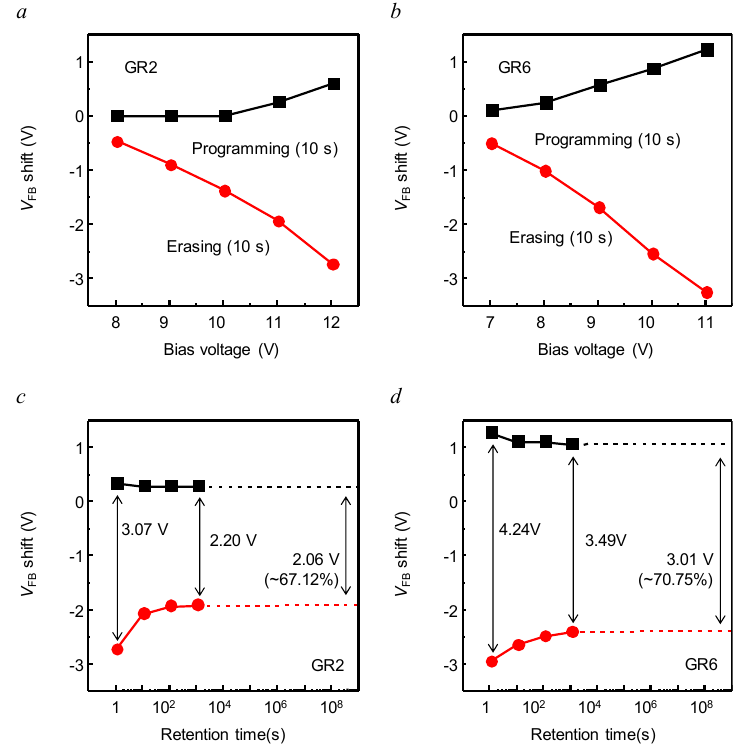
Figure 4. The operation voltages of programming/erasing charges trapped in MIS capacitors for bias voltage with different SiH 4 :N 2 O gas ratio for Si-rich SiO X charge trapping layer: ( a ) GR2 and ( b ) GR6, and extrapolated retention characteristics up to 10 years (10 9 s) of the Metal/SiO 2 /SiO X /SiO X N Y /Si capacitor with different SiH 4 :N 2 O gas ratio for Si-rich SiO X charge trapping layer: ( c ) GR2 and ( d ) GR6.